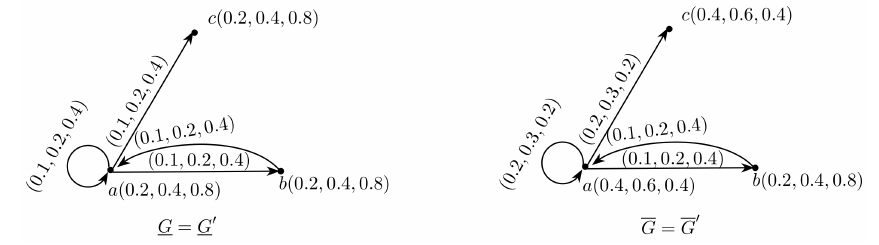
Figure 13. Self complementary RND G = ( G , G )